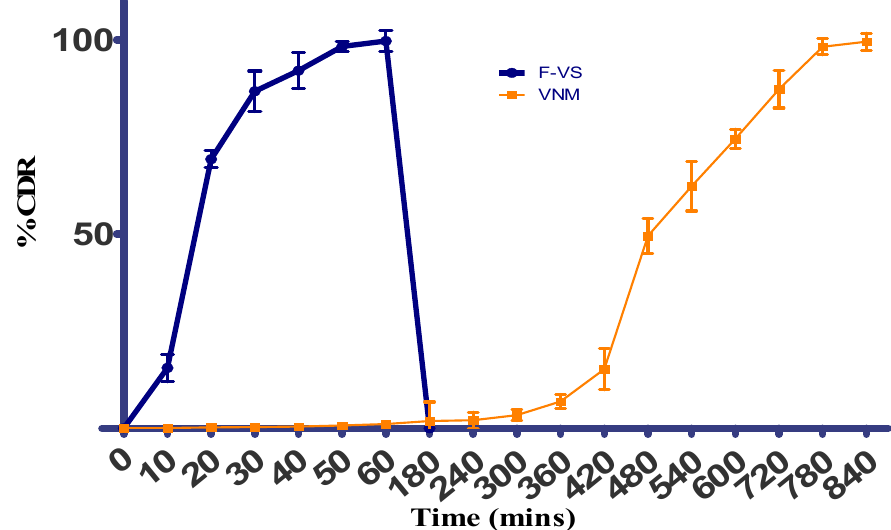
Figure 7. Bipulse drug release of tablet in capsule system.